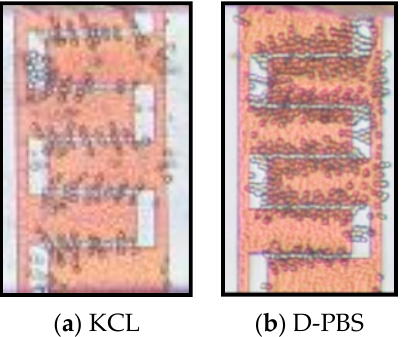
Figure 11. Differential separation of the live yeasts from live and dead (1:1) cell mixtures by DEP at 20 V pp , 20 MHz while dead cells were removed by nDEP: ( a ) cell mixture in KCL; ( b ) cell mixture in D-PBS.